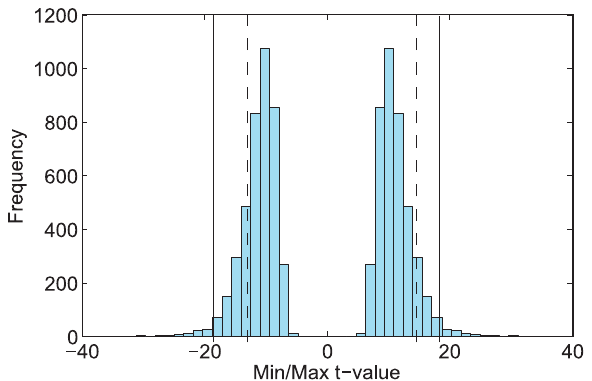
Figure 6. Distribution of maximum/minimum t-statistics across all permutations. Permutation distribution of maximum and mini- mum t-statistics across all matrix elements in a comparison between normocapnic and hypercapnic states. The solid lines represent p , 0.05 FWE corrected significance thresholds. The dashed lines represent the maximum and minimum t-statistics in the experimental labelling.